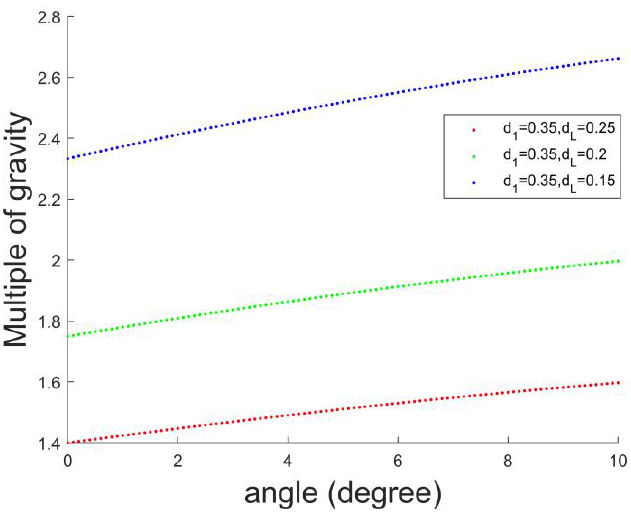
Figure 8. Influence of angle to the support force 2 N on absorbing module.